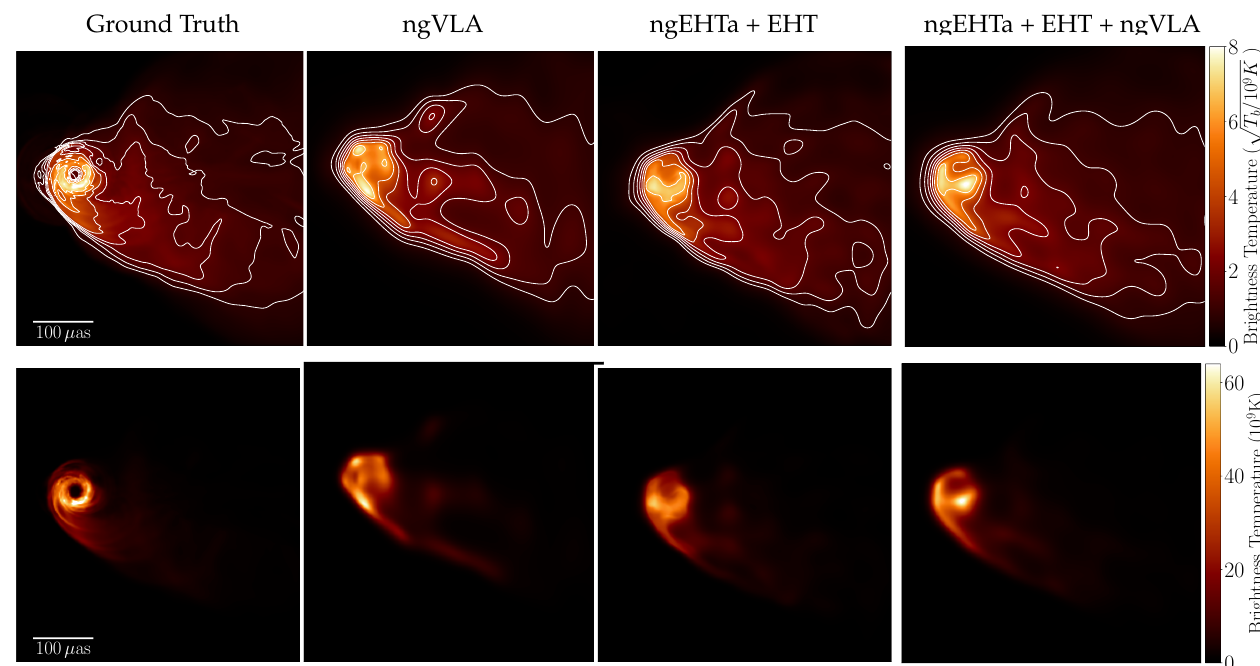
Figure 9. Comparison of the point source sensitivity (PSS, top panel, in units of Jy) and ( u , v ) -filling fraction (FF, bottom panel, unitless) metrics for several different array configurations. Each point shows the median metric value determined for 86GHz M87 observations across 100 Monte Carlo realizations of weather at every site and across each month of the year, and the errorbars indicate the 16th to 84th percentile ranges.